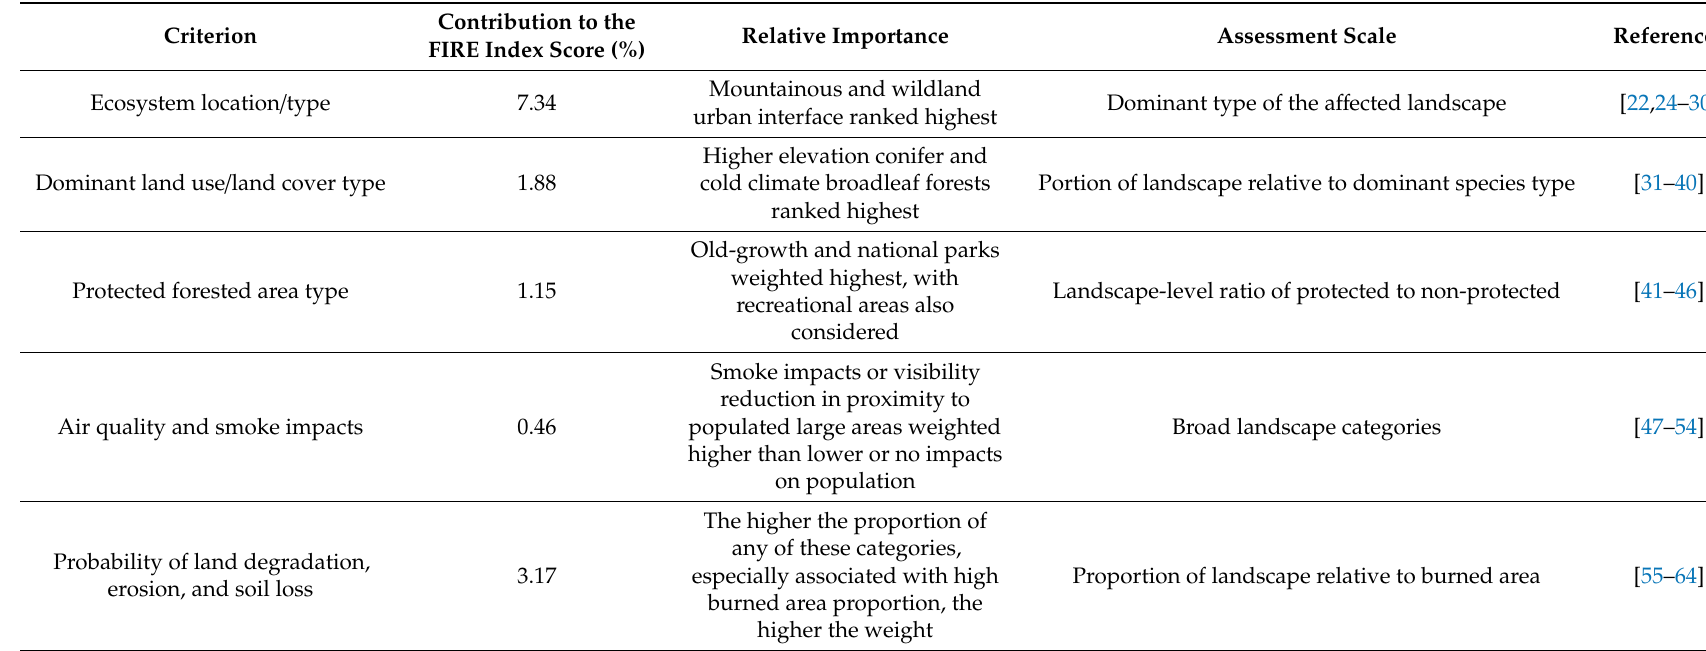
Table 1. Relative importance, assessment scale and relevant literature for each criterion for the e ff ects on landscape and vegetation fire e ff ects